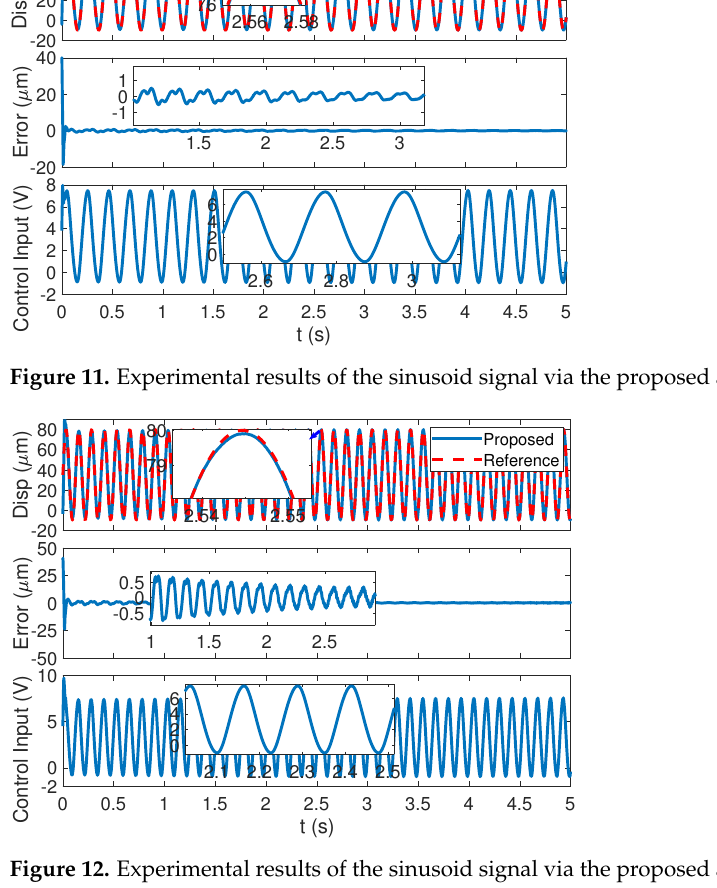
Figure 12. Experimental results of the sinusoid signal via the proposed algorithm (50